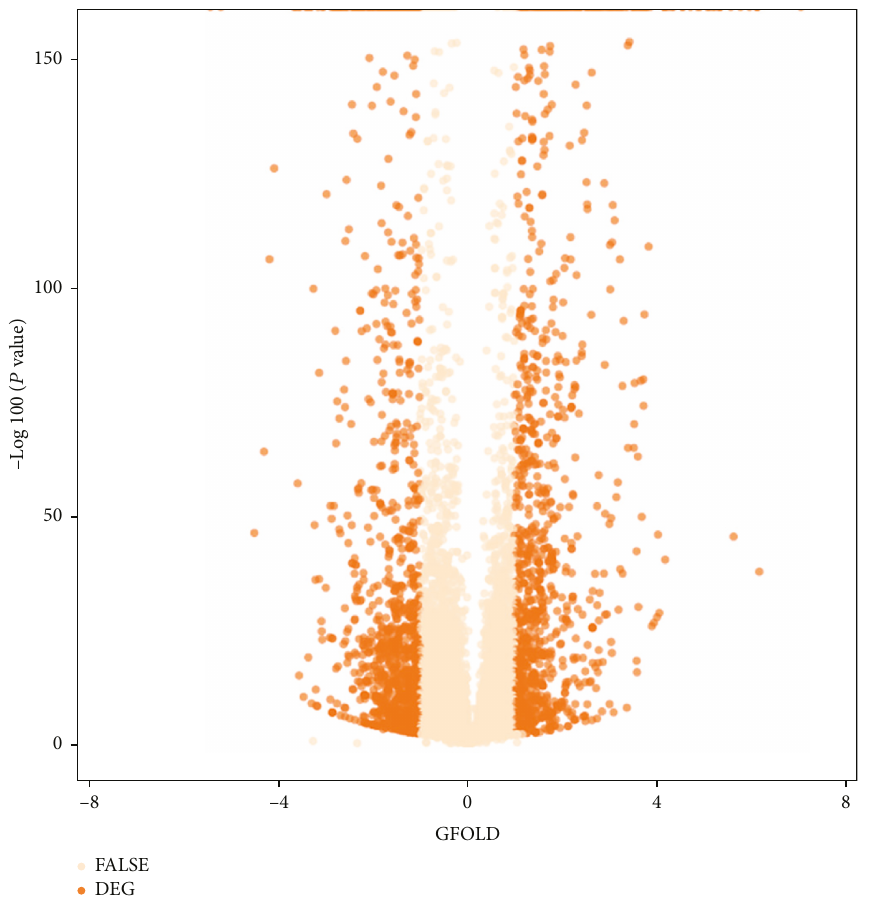
Figure 1: Volcano plot of genome-wide di ff erentially expressed genes of T1 vs . CK. Genes with P value < 10 -5 and GFOLD > 1 were indicated with colored dots and de fi ned as robust di ff erentially expressed ones (see Materials and Methods). DEG: di ff erentially expressed gene; FALSE: fi ltered by the criteria